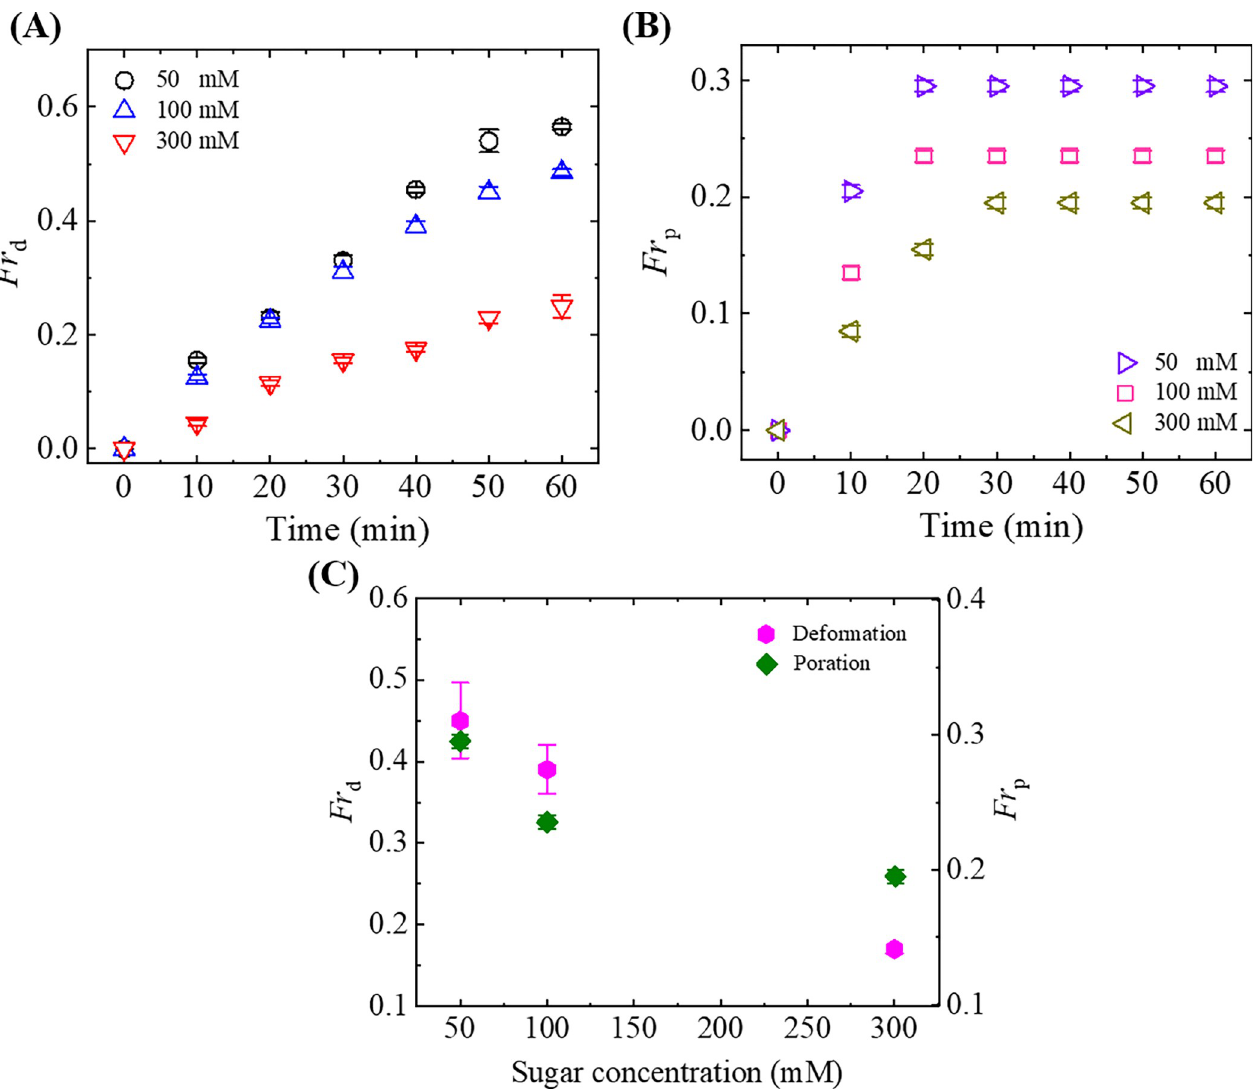
Fig 6. Fraction of deformed and pore formed DOPC-GUVs. The time-dependent (A) Fr d and (B) Fr p under 3.33 μ g/mL NPs at c = 50, 100 and 300 mM. (C) The sugar concentration-dependent Fr d and Fr p using 3.33 μ g/mL NPs at 40 min. The average values with standard deviations were obtained from 3 independent experiments containing 15–20 GUVs in each independent experiment.